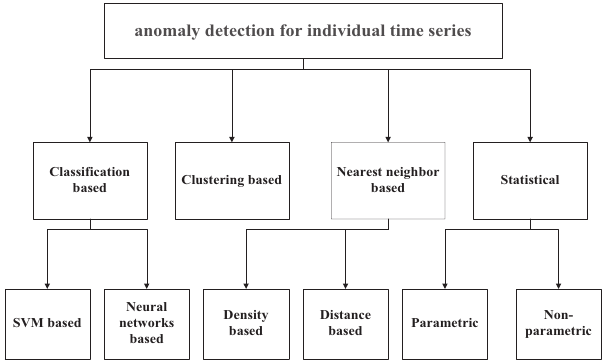
Figure 6. Classi fi cation of the anomaly detection method for a